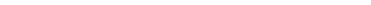
) , (cid:15) qV ee µµ